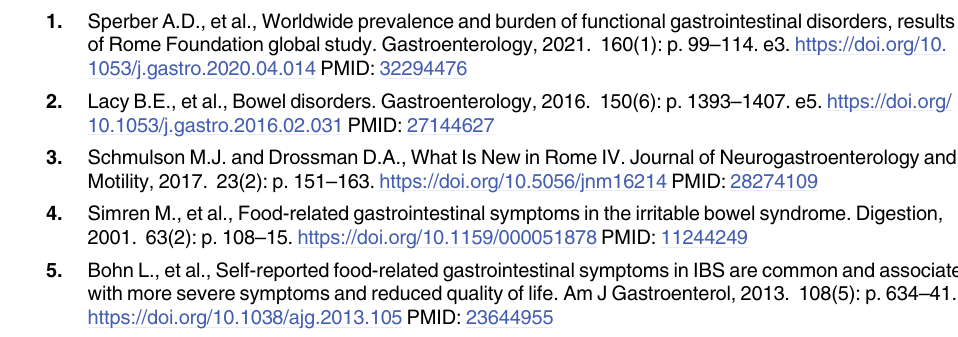
S1 Table. Reported dietary changes (post—Pre) among responders and non-responders to treatment with low FODMAP diet and traditional IBS